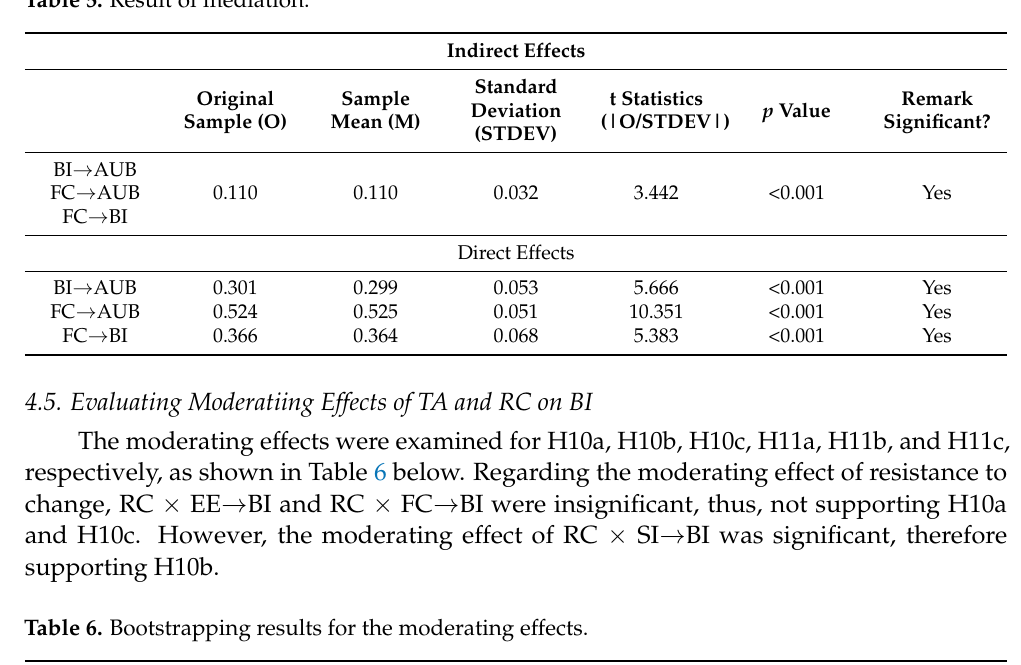
Table 5. Result of mediation.